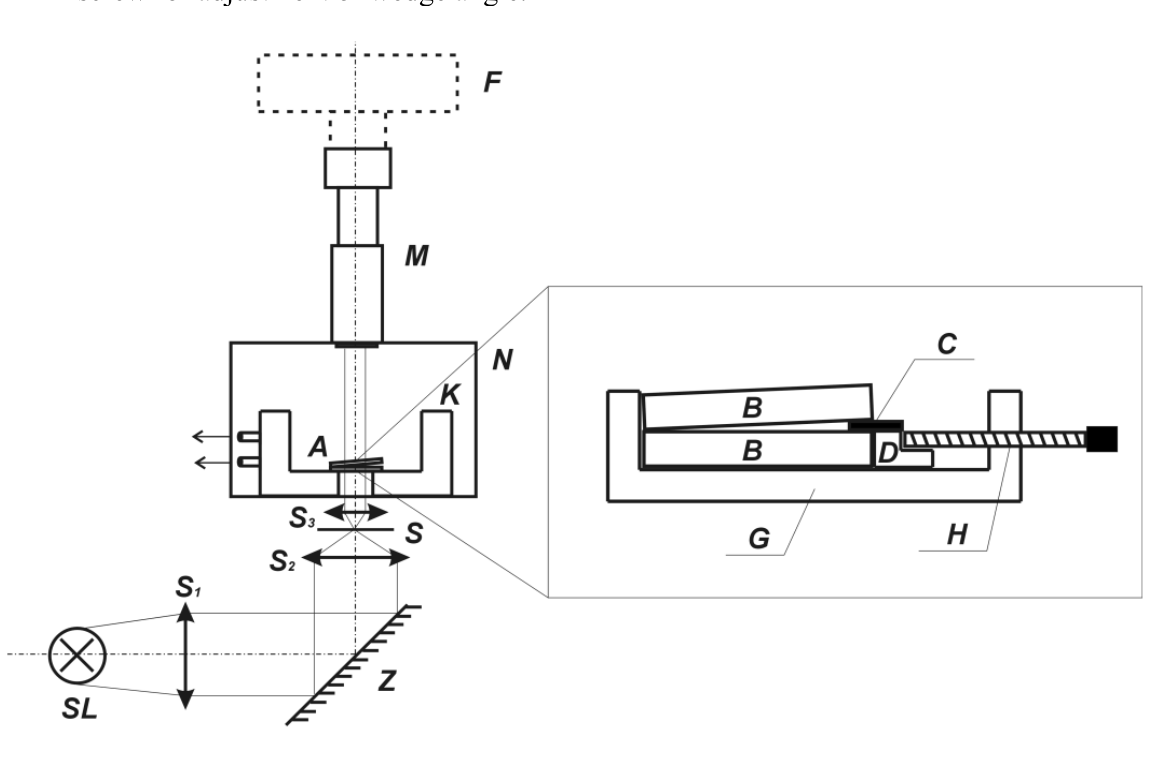
Figure 5. Schema of interferometer. SL – sodium-vapour lamp, S1–S3 –